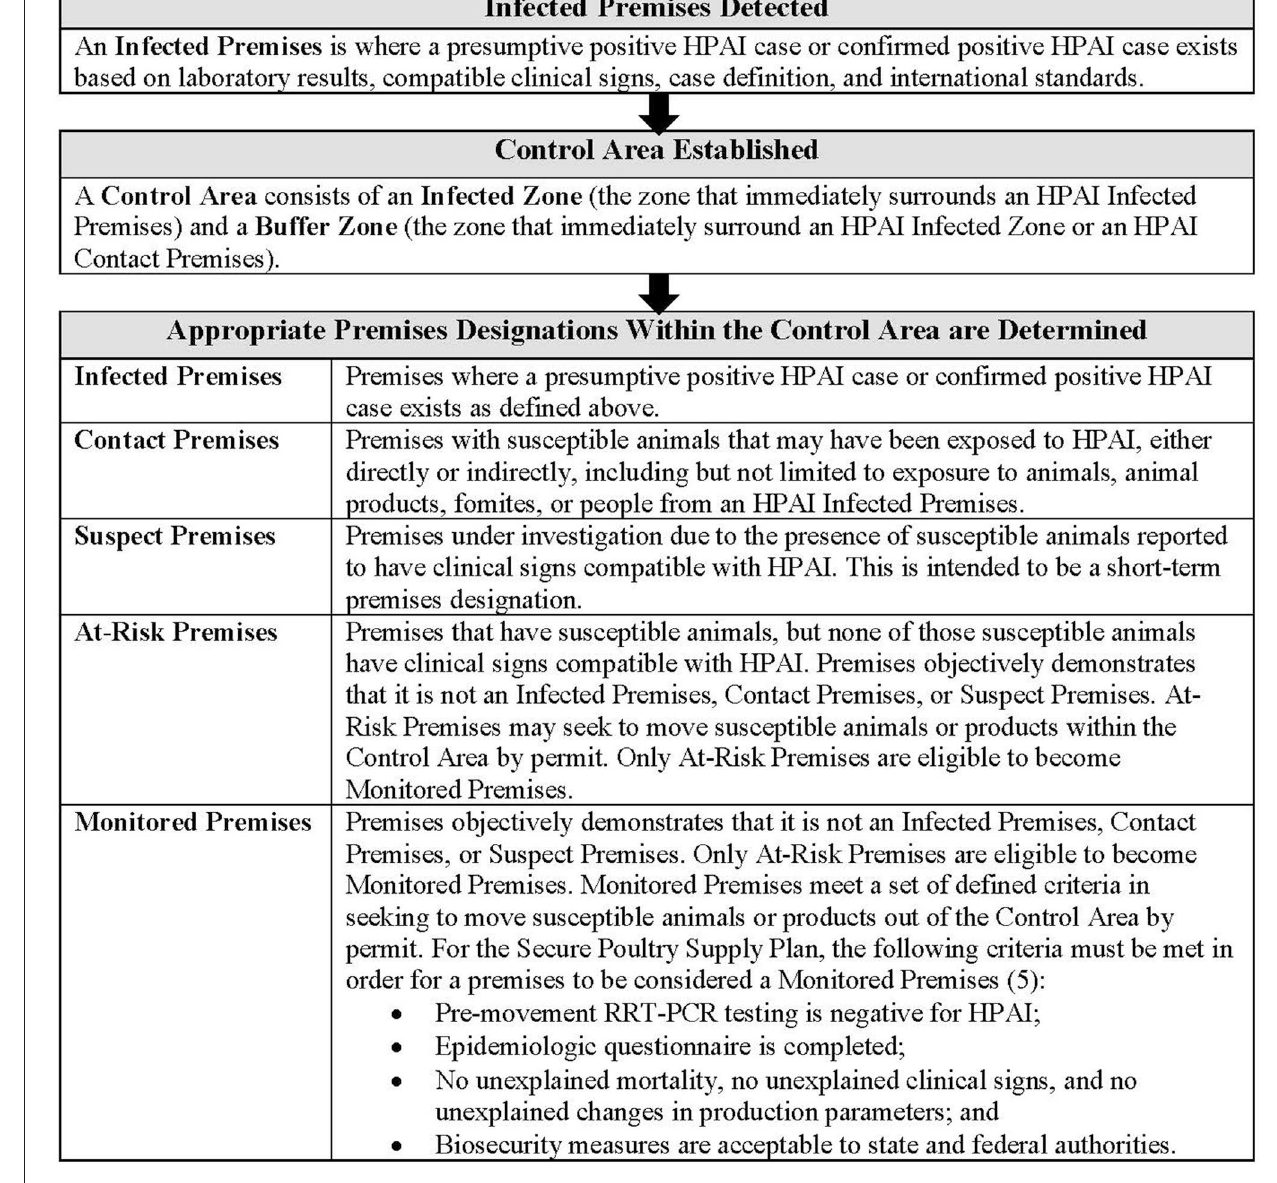
FIGURE 1 | USDA APHIS and Secure Poultry Supply Plan definitions of and steps leading to HPAI area, zone, and premises designations. Additional FAD zone, area, and premises designation definitions not applicable to this manuscript are available in The Red Book (3). Within the unified Incident Command*, the Incident Commander works with the Operations Section and Situation Unit (in the Planning Section) to determine zone, area, and premises designations. These designations are evaluated and reevaluated as needed throughout an outbreak based on the epidemiological situation; specific guidelines as to how to and who will conduct